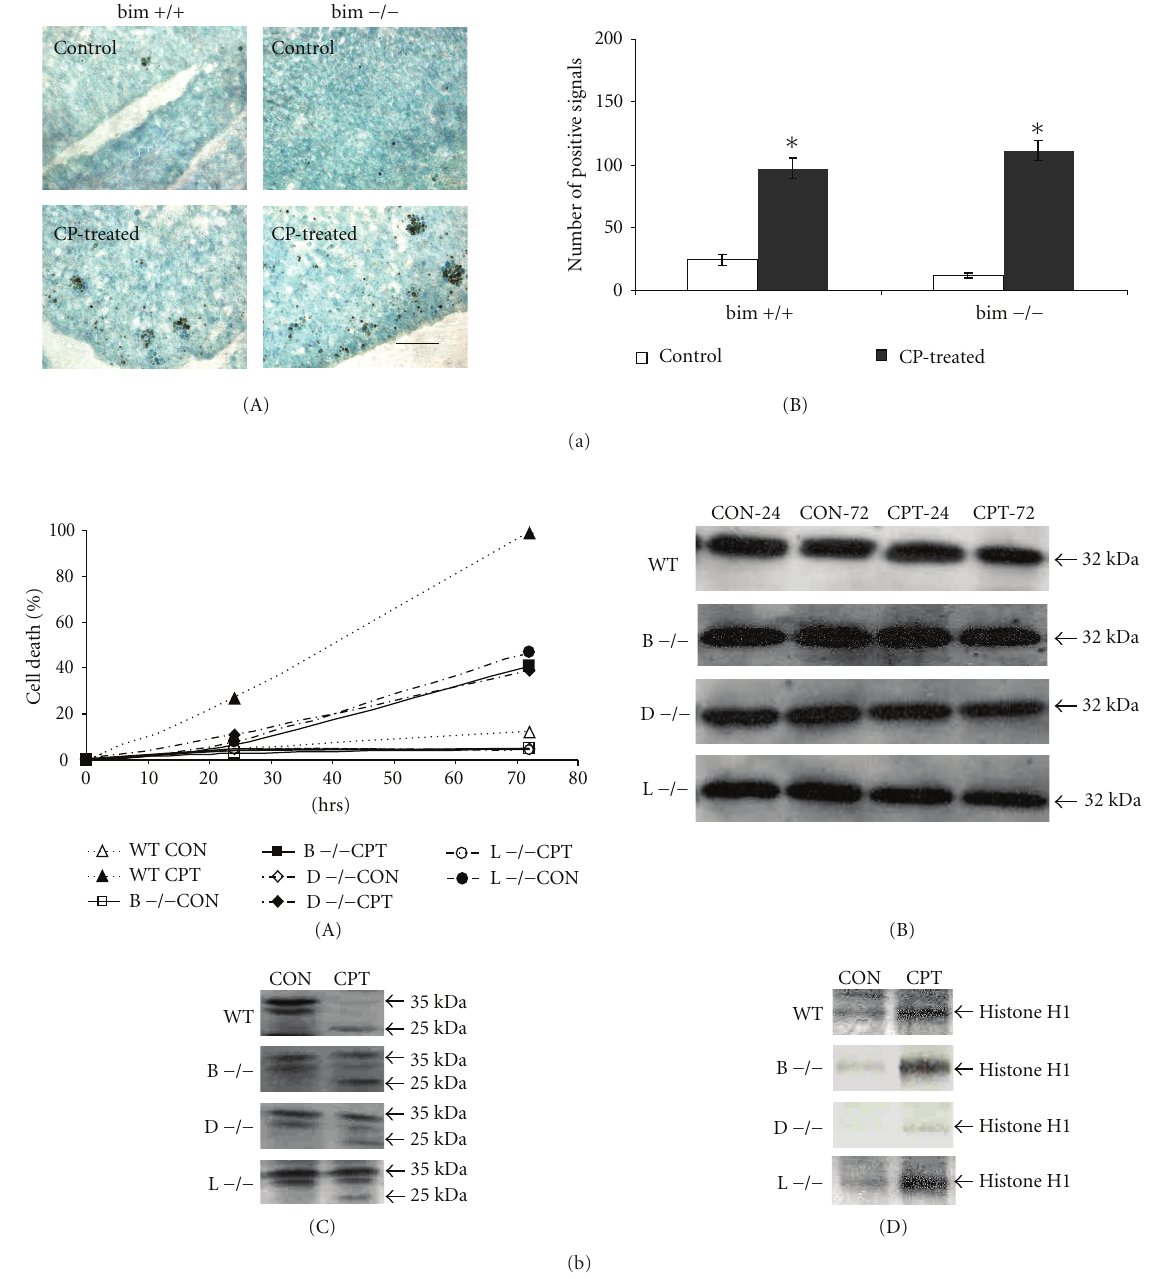
Figure 1: Cdk5 activation is independent of Bim and cathepsins. (a) Pregnant female mice were injected intraperitoneally as described in Section 2 . Cdk5 activation by immunohistochemistry showed many cells with Cdk5 activation labeled by Cdk5 antibody in bim + / + and bim − / − mouse embryos with or without CP treatment, 400X. (A) Positive signals were counted in 3–5 fields of 400X, and the number of positive signals per field was used for plot and analyzed by t-test. (B) The error bars represent the standard deviation from at least three individual experiments ( ∗ P < . 05 ). (b) Wild type and cathepsin B, D, and L − / − cells were incubated with CPT (50 μ M). (A) At 24 and 72hours, the amount of cell death was determined by trypan blue exclusion. The error bars represent standard deviation obtained from at least 3 independent experiments. Protein samples were isolated from cells with RIPA bu ff er. (B) Western blot analysis of equal amounts of cell lysates from cells using Cdk5 antibody showed an unchanged level of Cdk5 protein (32kDa) during cell death. (C): Equal amounts of cell lysates from wild type and cathepsin B, D, and L − / − cells incubated with CPT (50 μ M) for 72hours were used for western blot